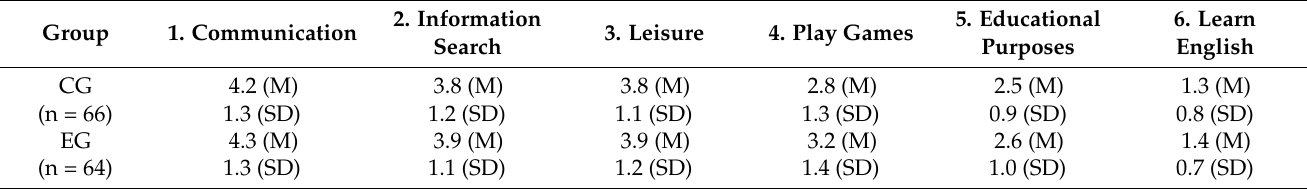
Table 2. Purposes of smartphone usage.